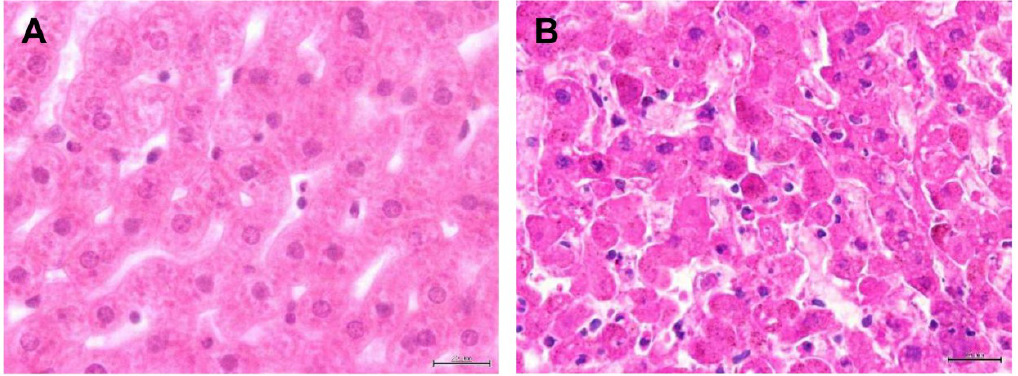
Figure 2. Histopathological characterization of the new rabbit hemorrhagic disease virus (RHDV) variant in Portuguese samples. ( A ) Liver section of a healthy rabbit. Staining H&E, scale bar = 20 µm; (B) Liver with lesions of microvacuolar degeneration and necrotizing hepatitis with karyolysis. Staining H&E, scale bar = 20